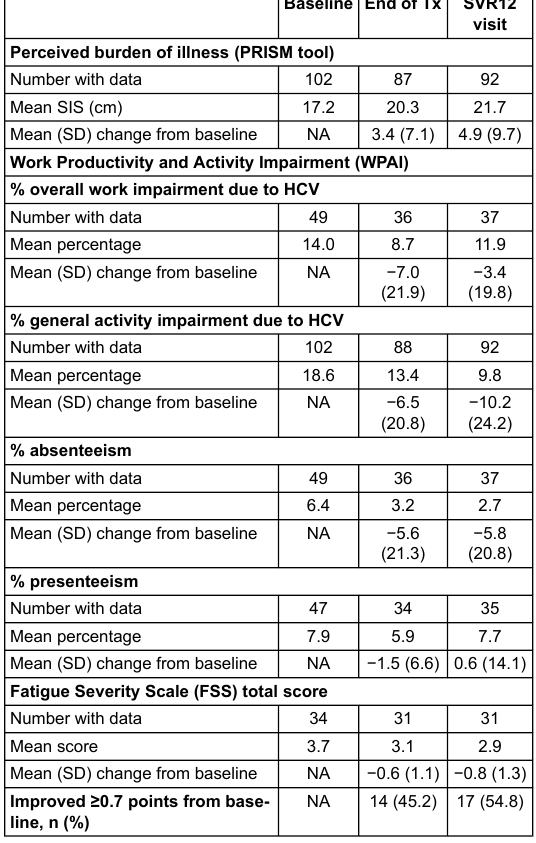
Table 3: Summary of patient-reported outcomes (patients with data